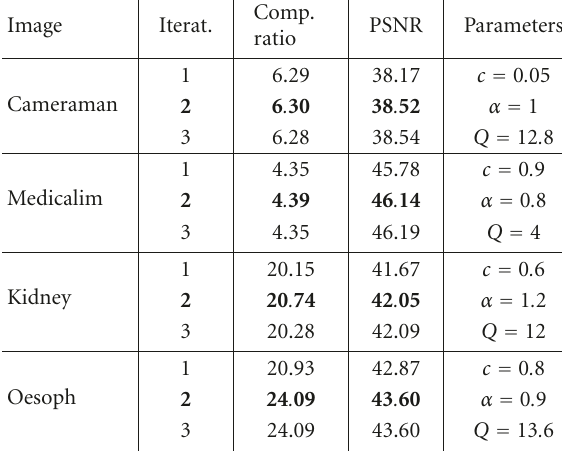
Table 1: Simulation results of Algorithm 2